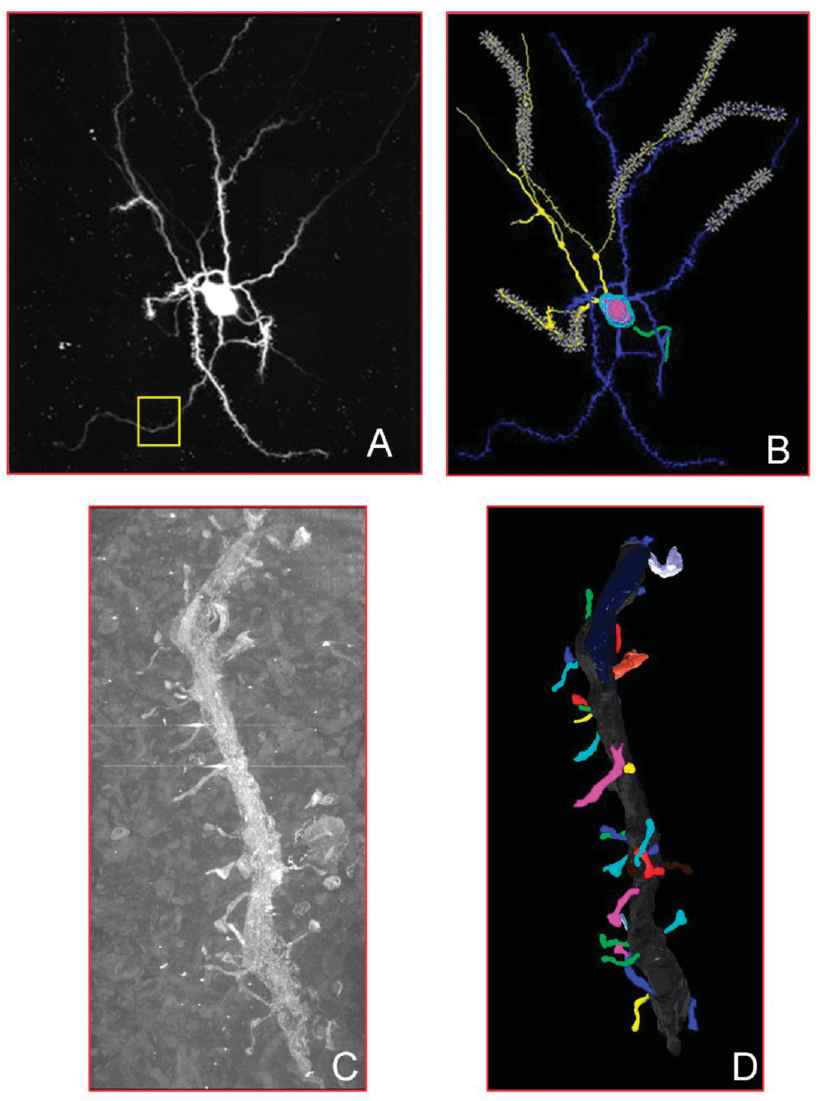
Figure 1. Multiple representations of the same medium spiny neuron taken from the CCDB . In ( A ), a light-level fill of the neuron. The yellow box shows the portion of the dendritic branch shown in ( C ). In ( B ), the Neurolucida segmentation of that neuron. In ( C ), the EM image of the portion of the dendrite featured in ( A ). In ( D ), the 3D reconstruction of the dendrite from ( C ) after